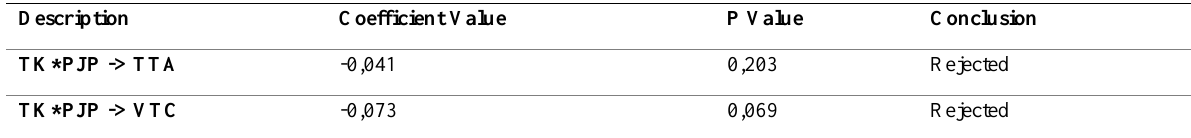
Table 7: Phase 2 Test